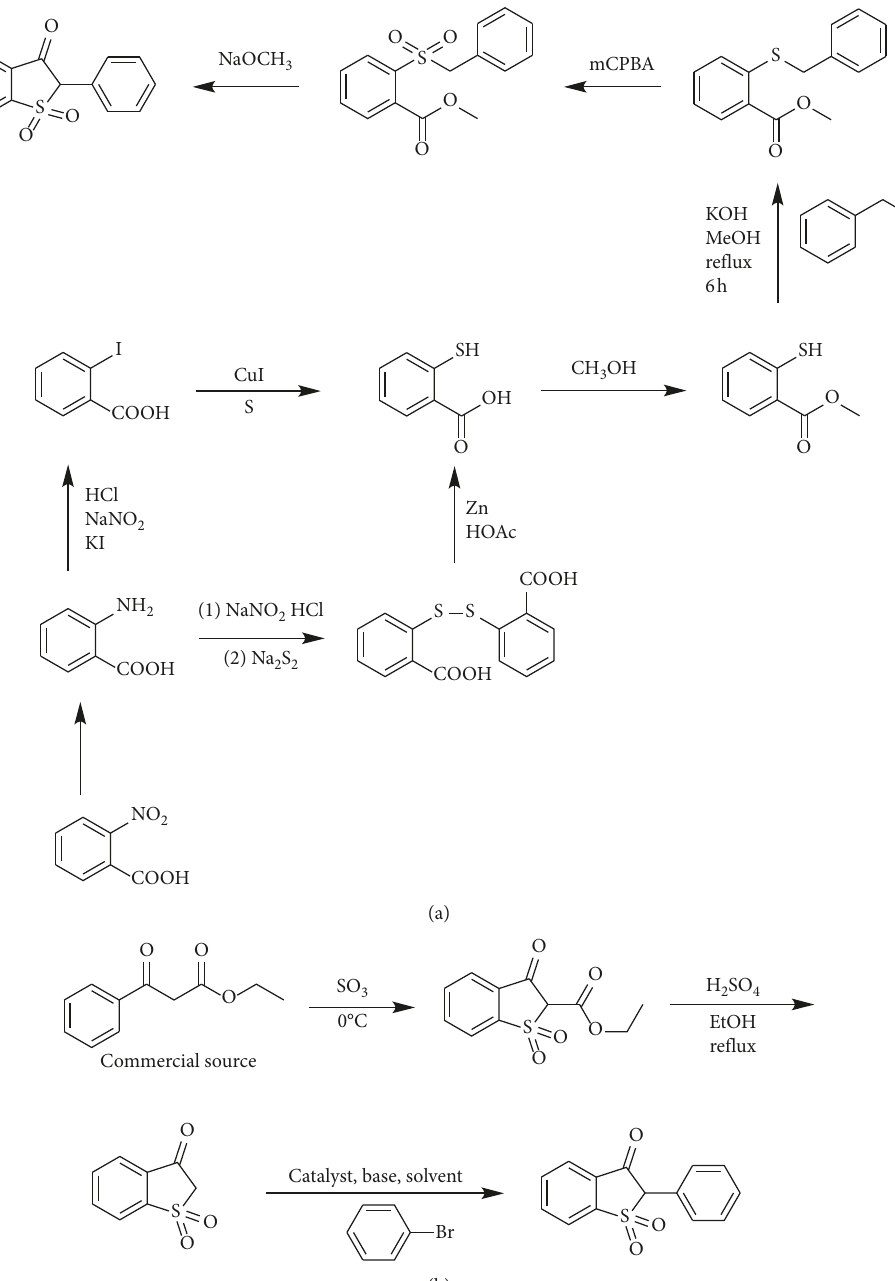
Scheme 1: Traditional route vs. our